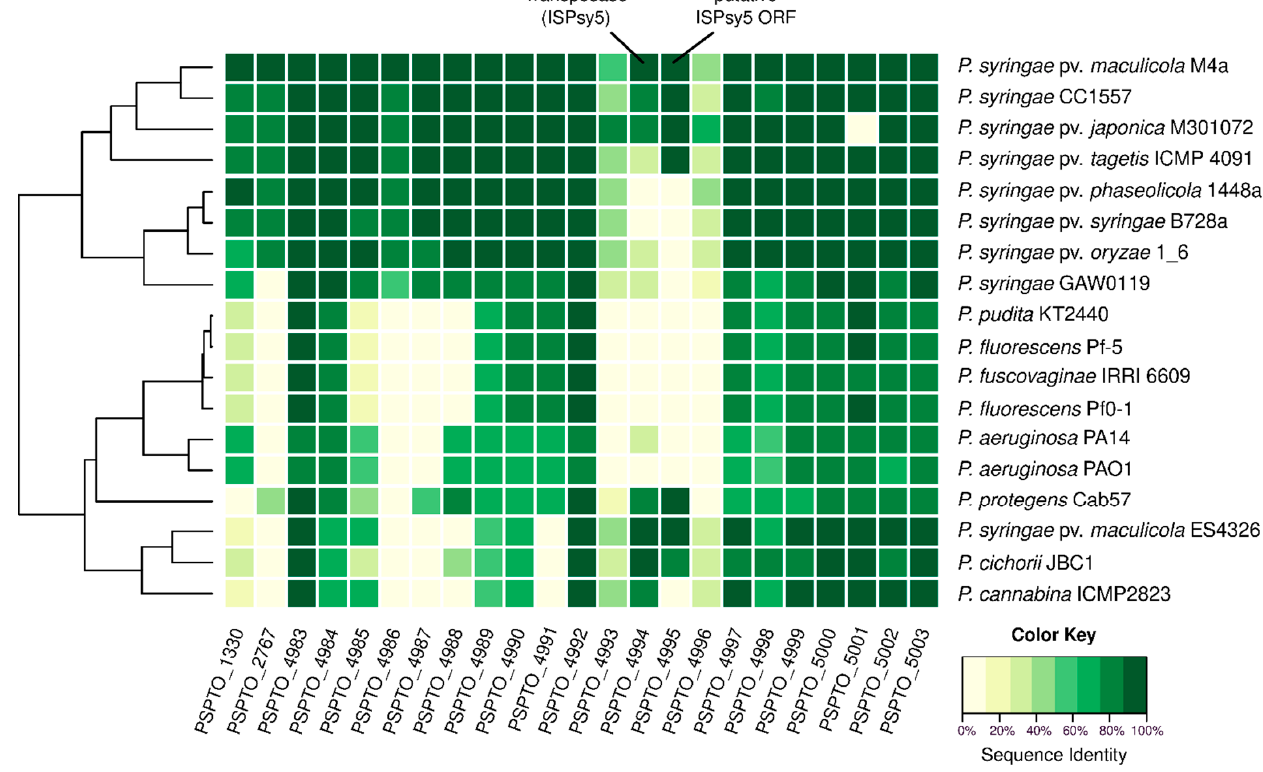
Figure 1. Comparison of core-OS synthesis enzymes. Heatmap of results from an NCBI BLASTP search for homologous core-OS biosynthetic enzymes in different predicted proteomes (Table S1). Pst DC3000 sequences were used as reference, e-value cutoff = 10 − 9 . Sequence identity values of the BLASTP results are provided in Supplementary Data File 1. Dendrogram according to Euclidean distances calculated from the BLASTP results.